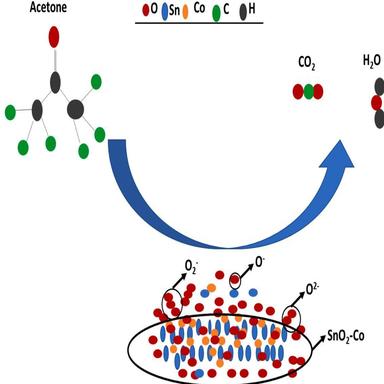
The acetone sensing mechanism of SnO2-Co sensor. (For interpretation of the references to colour in this figure legend, the reader is referred to the web version of this article.)